Question: Express in one sentence what the figure is showing.
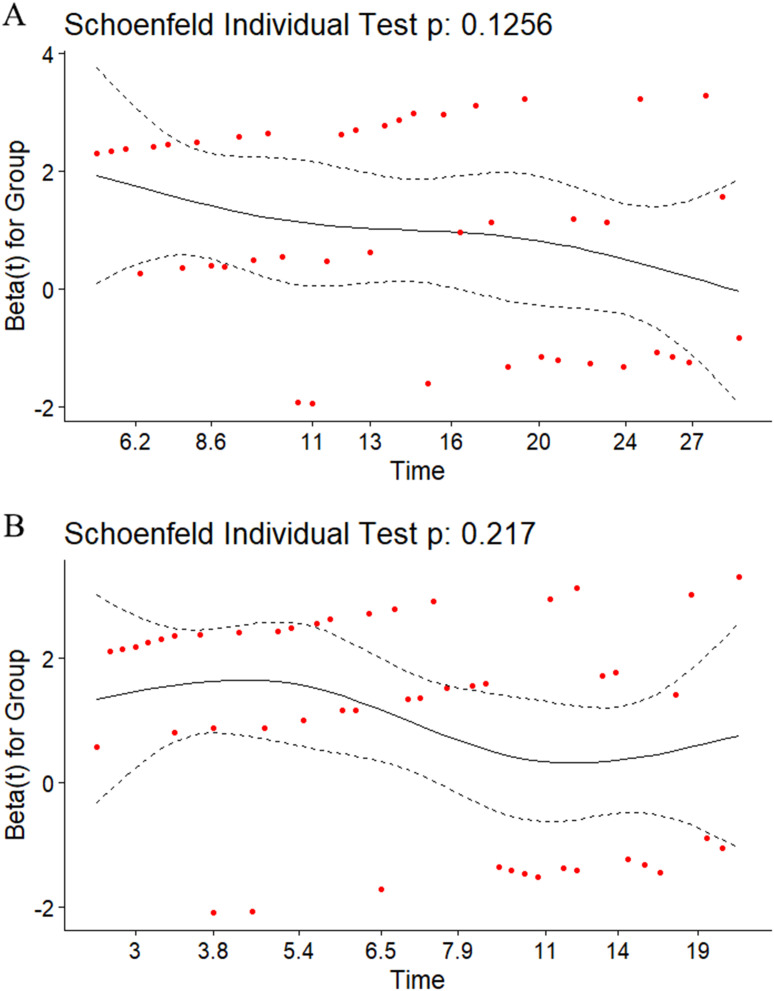
Answer: Schoenfeld residual analysis for (A) overall survival and for (B) progression-free survival across the three groups.